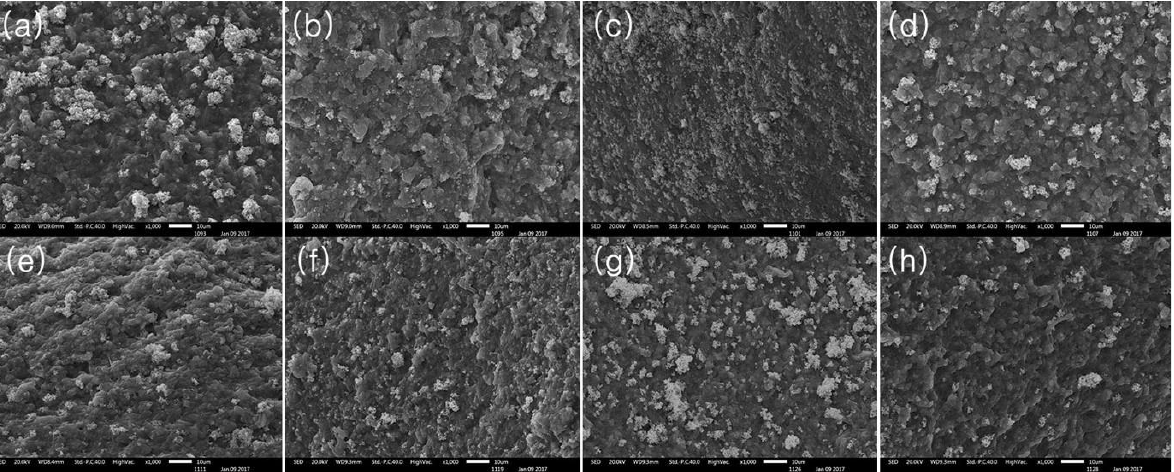
Figure 3. Microstructure of myofibrillar protein mixtures with various additional levels of gelatin and transglutaminase (TGase). ( a ) Control. ( b ) Gelatin 0.5 g/100 g. ( c ) Gelatin 1.0 g/100 g. ( d ) Gelatin 1.5 g/100 g. ( e ) Control with TGase. ( f ) Gelatin 0.5 g/100 g with TGase. ( g ) Gelatin 1.0 g/100 g with TGase. ( h ) Gelatin 1.5 g/100 g with